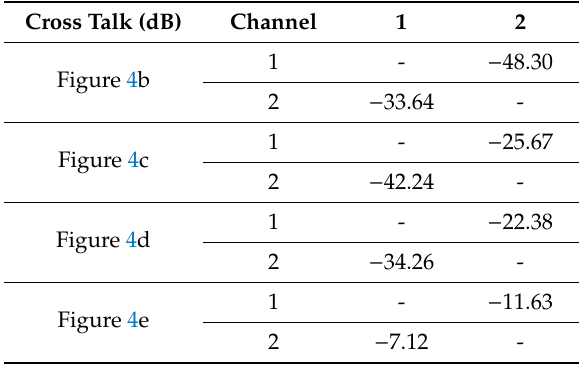
Table 3. Cross talk values of the proposed demultiplexer in dB Cross Talk